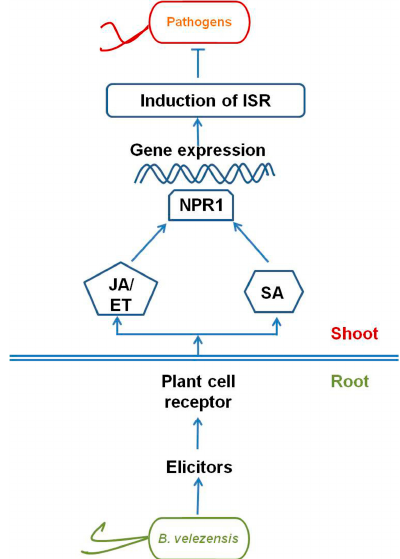
Figure 4. Signal transduction pathway of induced systemic resistance stimulated by B. velezensis . NPR1: non-expressor of PR1; JA/ET: the jasmonic acid/ethylene signaling pathways; SA: Salicylic